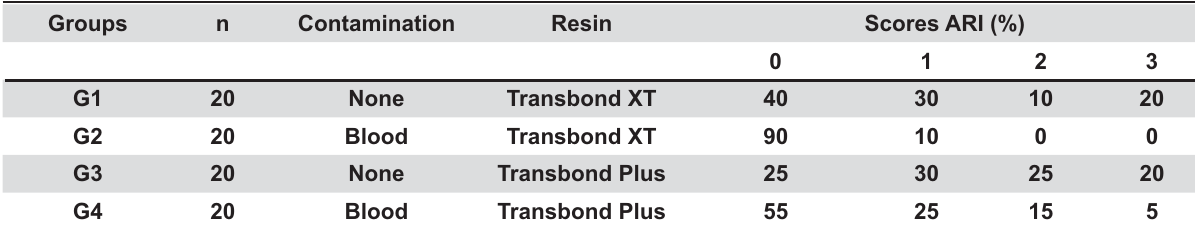
Table 1- Descriptive statistic for shear bond strength Groups